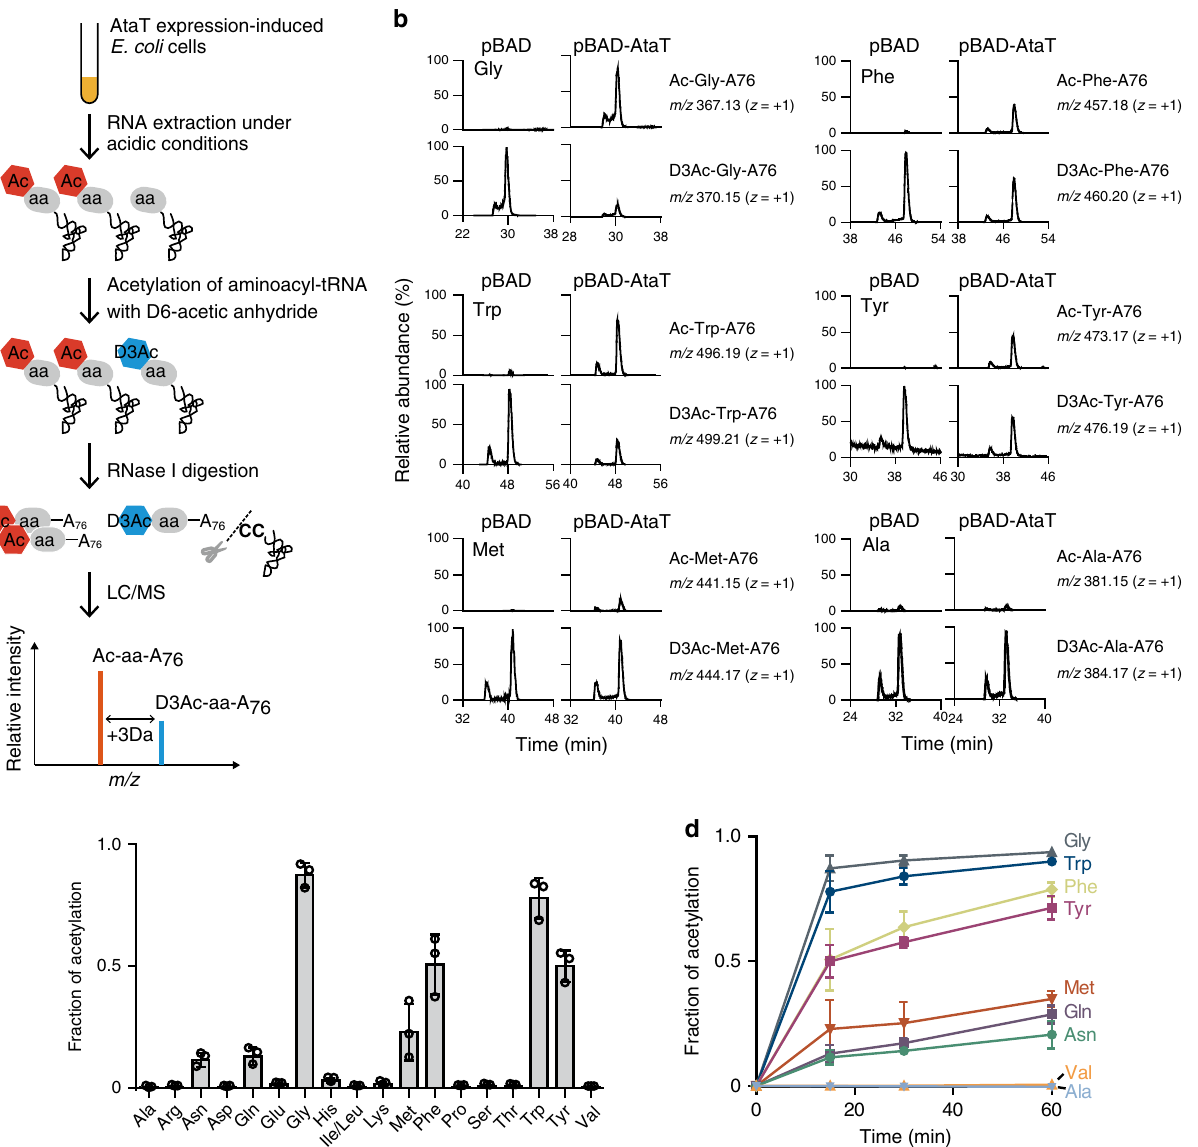
Fig. 4 Acetylation of aminoacyl-tRNAs by AtaT in vivo. a Schematic diagram of the LC/MS detection and quanti fi cation of acetyl-aminoacyl-tRNAs, produced by the action of AtaT in vivo. b LC/MS analysis of RNase I-digested fragments of acetyl-aminoacyl-tRNAs after 15 min of induced AtaT expression (pBAD-AtaT) and the negative control (pBAD). Extracted ion chromatograms of the proton adducts corresponding to Ac-Gly-A76 ( m/z = 367.13), Ac-Trp-A76 ( m/z = 496.19), Ac-Phe-A76 ( m/z = 457.18), Ac-Tyr-A76 ( m/z = 473.17), Ac-Met-A76 ( m/z = 441.15), and Ac-Ala-A76 ( m/z = 381.15), derived from Ac-Gly-tRNA Gly , Ac-Trp-tRNA Trp , Ac-Phe-tRNA Phe , Ac-Tyr-tRNA Tyr , Ac-Met-tRNA Met , and Ac-Ala-tRNA Ala isoacceptors, respectively. The two peaks observed for each Ac-aa-A76 are likely attributable to structural isomers of 3 ′ -acetyl-aminoacyl-A76 and 2 ′ -acetyl-aminoacyl- A76, as 3 ′ -O-methyl and 2 ′ -O-methyl nucleotides are known to be separated in a similar manner 40 . c Fractions of aminoacyl-tRNAs acetylated by the action of AtaT in vivo. The amounts of Ac-aa-A76 and D3Ac-aa-A76, after 15 min of AtaT expression induction, were quanti fi ed, and the fractions of individual aminoacyl-tRNAs acetylated by AtaT in vivo were estimated as the ratio of Ac-aa-A76 to the sum of the amounts of Ac-aa-A76 and D3Ac-aa- A76. The bars in the graph are SD of three independent ( n = 3) experiments, and the data are presented as mean values ± SD. d Time courses of the fractions of aminoacyl-tRNAs acetylated by AtaT in vivo. The bars in the graphs are SD of three independent